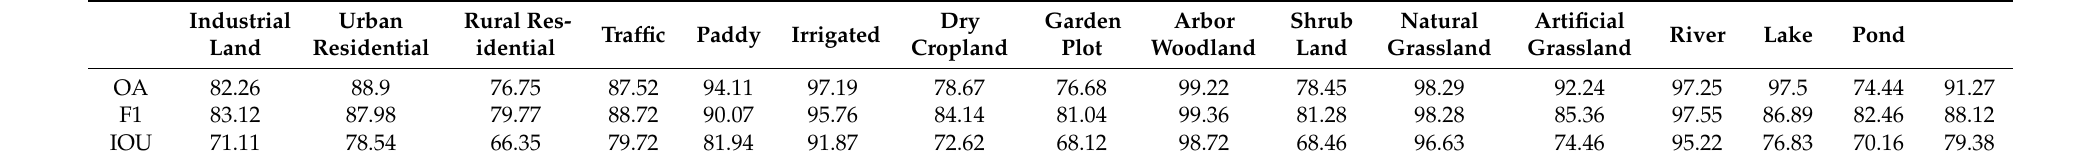
Table 7. The results of RE-Net on